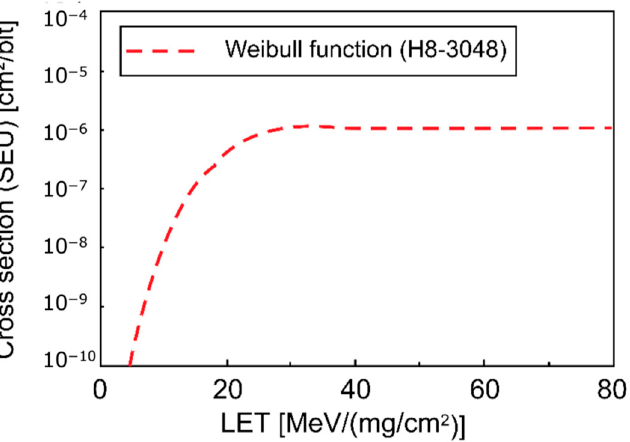
Figure 11. LET–SEU upset cross-section characteristic curve (microcomputer: H8-3048. Reprinted from [21]).